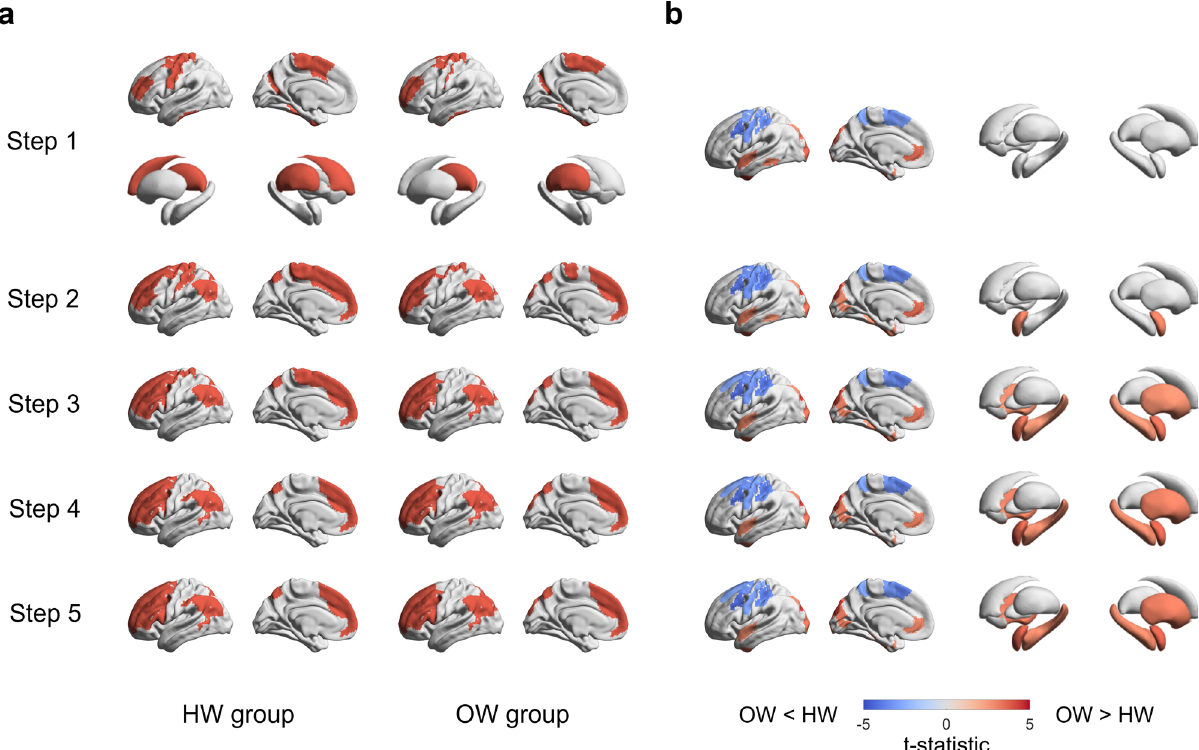
Fig. 3 Stepwise functional connectivity in healthy weight (HW) and overweight (OW) groups. a Hub regions from step distance one to fi ve for each group ( n = 104 for HW; n = 75 for OW) are reported on brain surfaces. Hub regions in subcortical areas were detected only in the fi rst step. b We reported the t-statistics of brain regions that showed signi fi cant between-group differences in degree centrality between individuals with HW and OW. Regions with red show a higher degree in OW group compared to individuals with HW, and blue regions, vice versa.